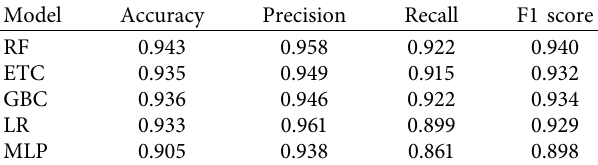
Table 9: Results of machine learning models with CC